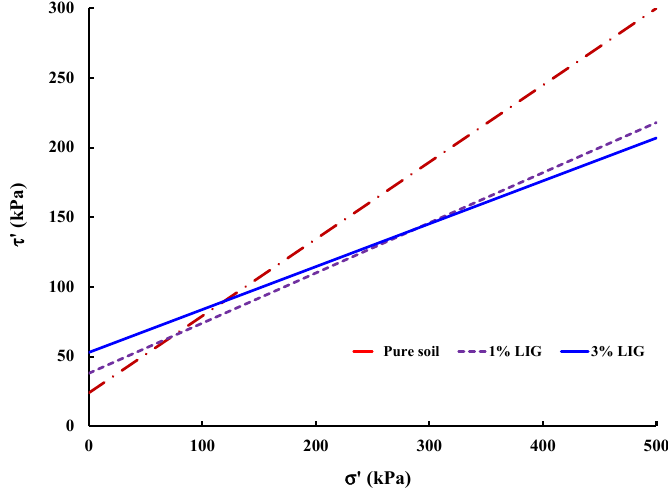
Figure 6. Effective shear stress vs. effective normal stress curves.